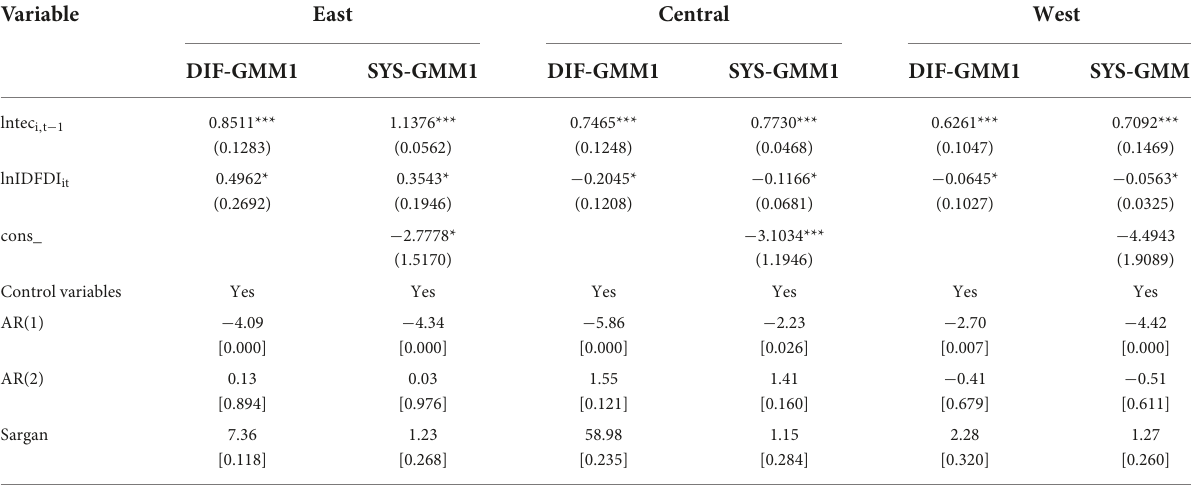
TABLE 7 Environmental technology effects of two-way foreign direct investment (FDI) interactive development in the subregion.